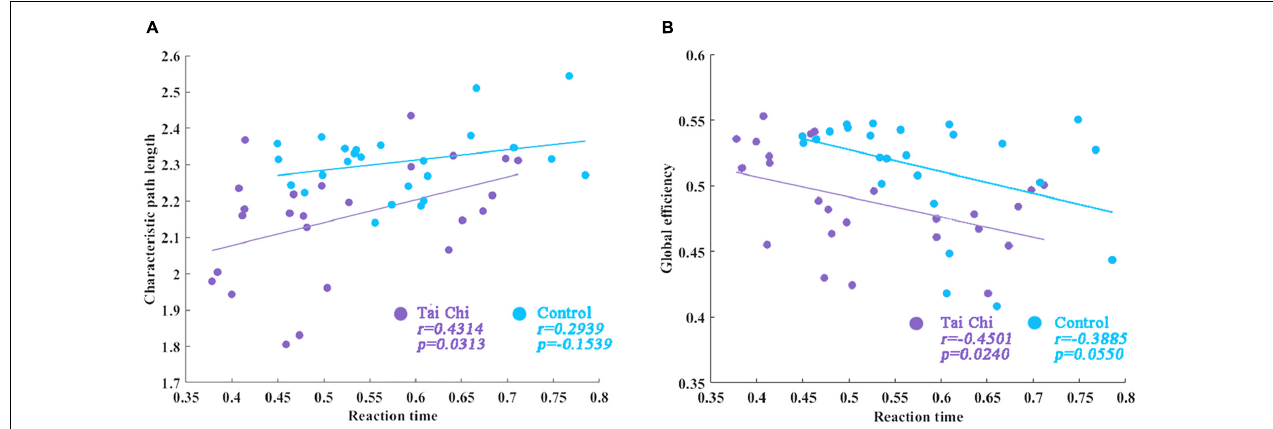
FIGURE 3 | The correlation between reaction time and global network topological properties. (A) The correlations between response time and characteristic path length of subjects in TC group. (B) Correlation between reaction time and global efficiency in the TC group.